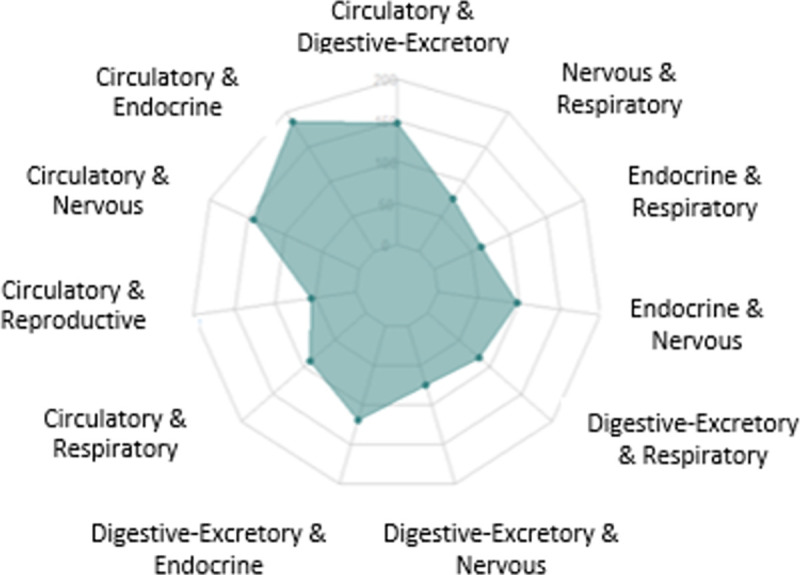
Combinations of human systems’ diseases among people with multimorbidity.